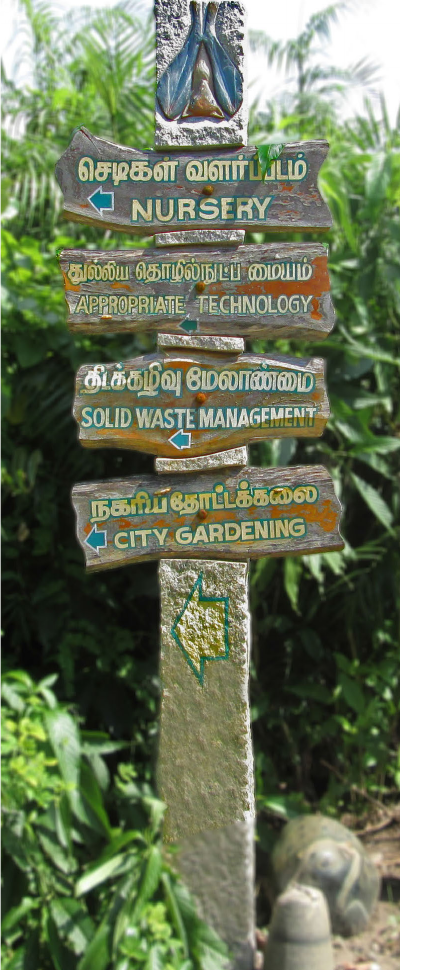
Image 10. A directional sign with a Short-nosed Fruit Bat Cynopterus sphinx carved at the top. Adyar Eco Park, Chennai.